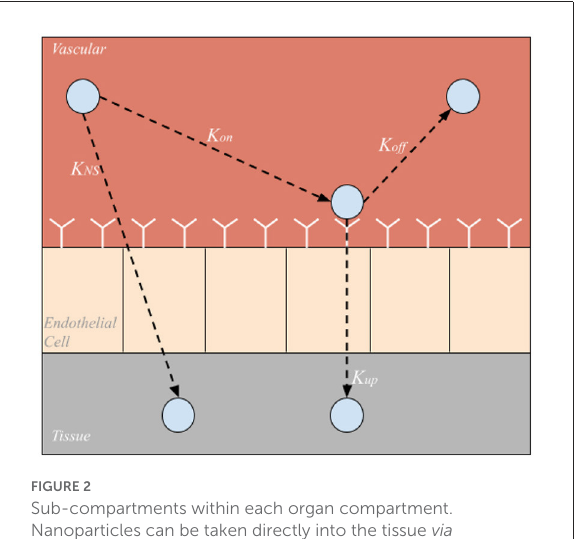
FIGURE2 Sub-compartments within each organ